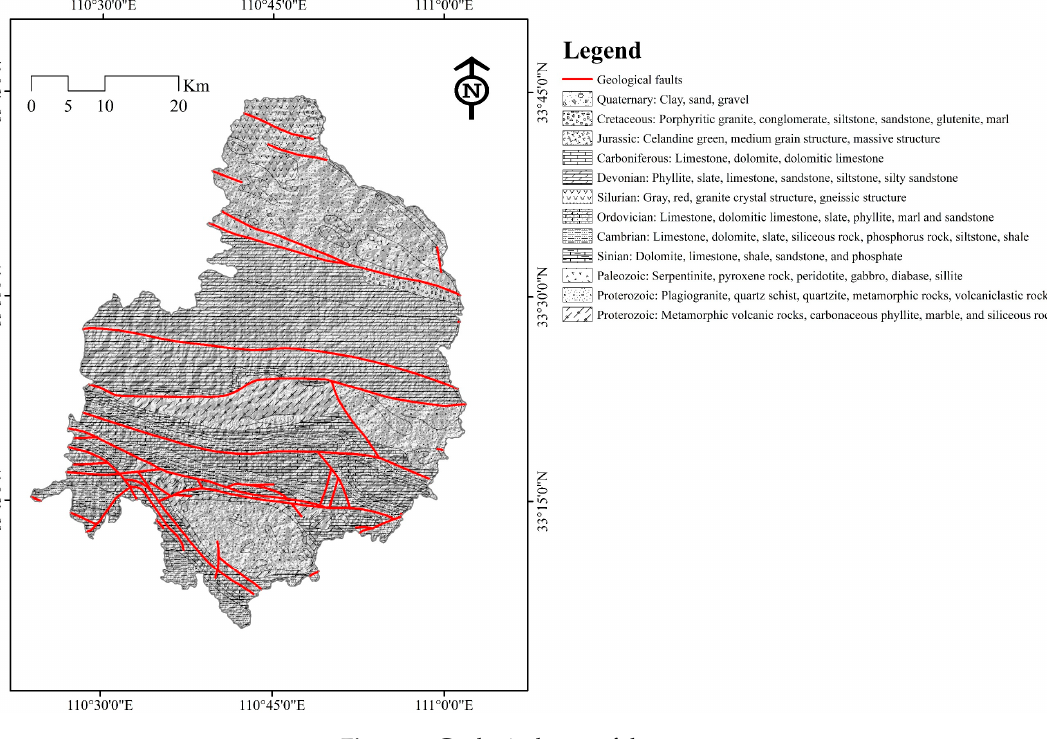
Figure 2. Geological map of the area.